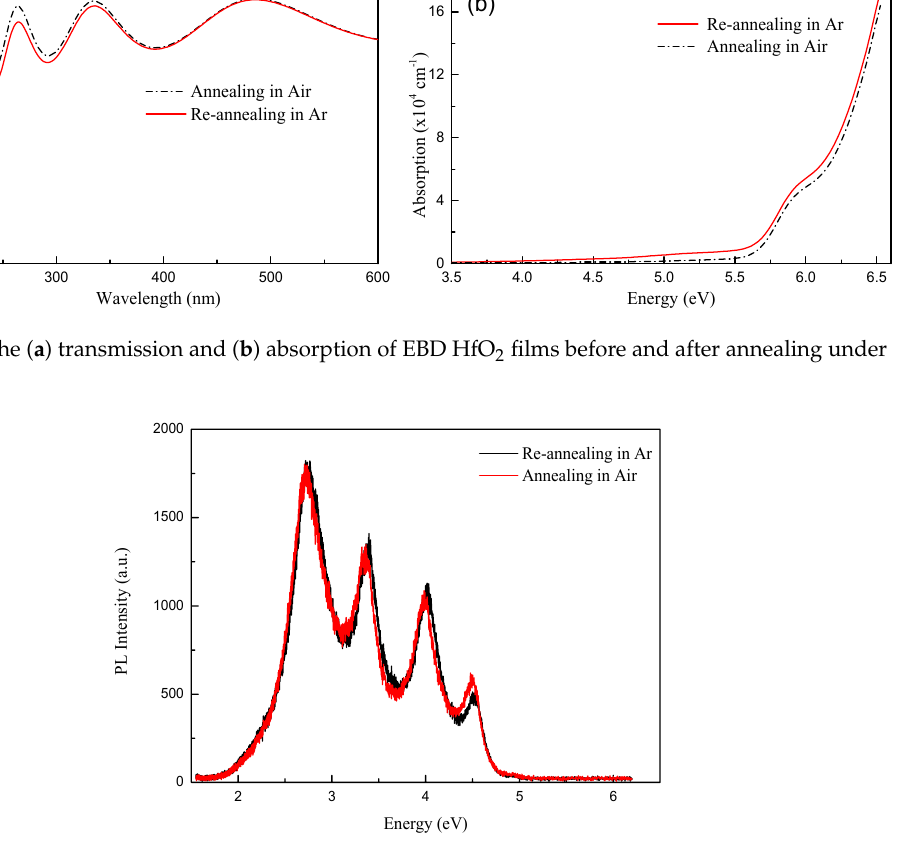
Figure 6. The PL spectra of the EBD HfO 2 film before and after re-annealing in Ar gas, excited by 193 nm laser irradiation.